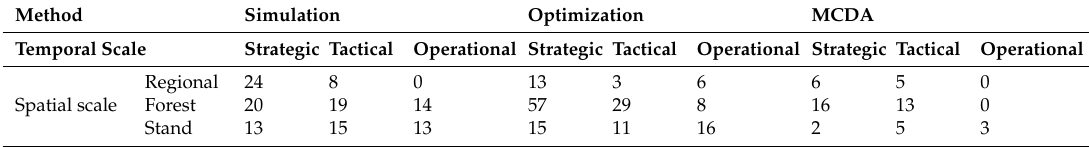
Table 7. Breakdown of method group instances by problem type (temporal and spatial scale).